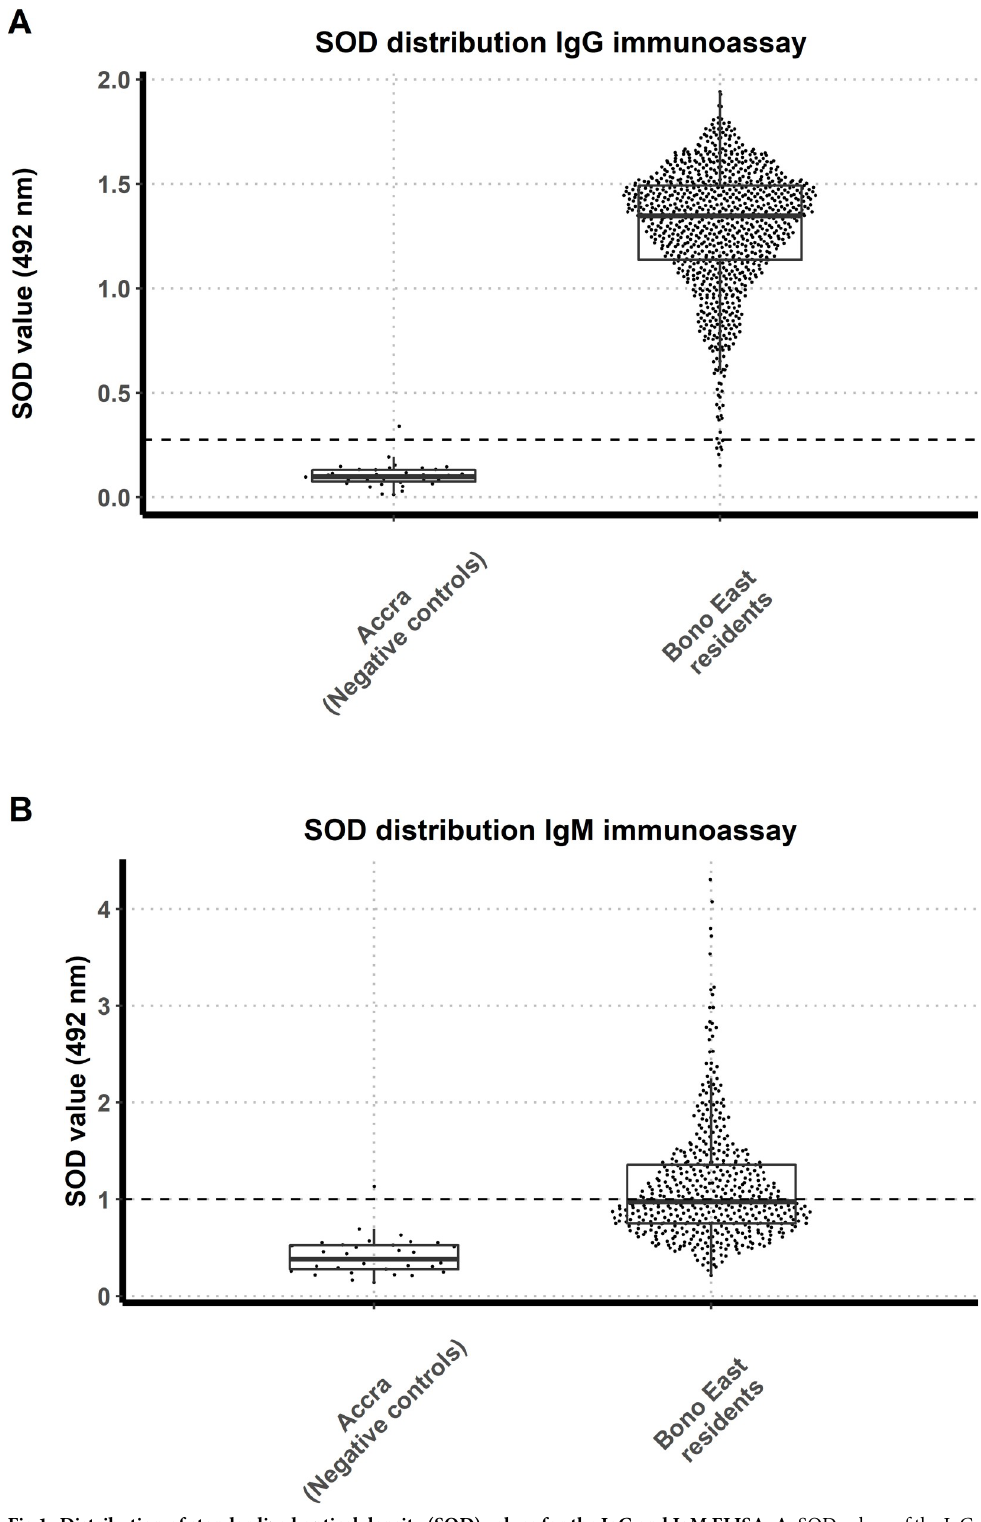
Fig 1. Distribution of standardized optical density (SOD) values for the IgG and IgM ELISA. A. SOD values of the IgG ELISA for negative control samples (n = 35) from Accra and Bono East region residents (n = 958), Ghana. The cut-off value is shown by a dashed horizontal line and is equal to 0.275 SOD. B. SOD values of the IgM ELISA for negative